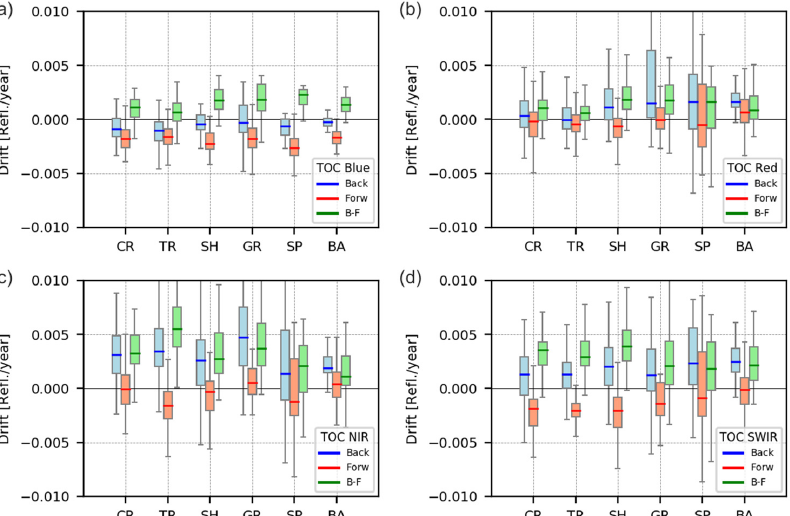
Figure 12. The figure shows boxplots of estimated drifts in TOC products aggregated per land cover class for the backward (blue) and forward (red) scattering directions, and their differences (green). Results are presented for bands: ( a ) Blue, ( b ) Red, ( c ) NIR, ( d ) SWIR. Aggregation is performed per land cover class: Crop (CR), Tree (TR), Shrubland (SH), Grassland (GR), Sparse vegetation (SP), Bare soils (BA). The height of the box extends from the upper to the lower quartile, Q 3 and Q 1 , corresponding to the 75th and 25th percentiles, respectively. The median is plotted inside the box and the bars extend to 1.5 × IQR from the lower and upper quartiles, where IQR = Q 3 − Q 1 .